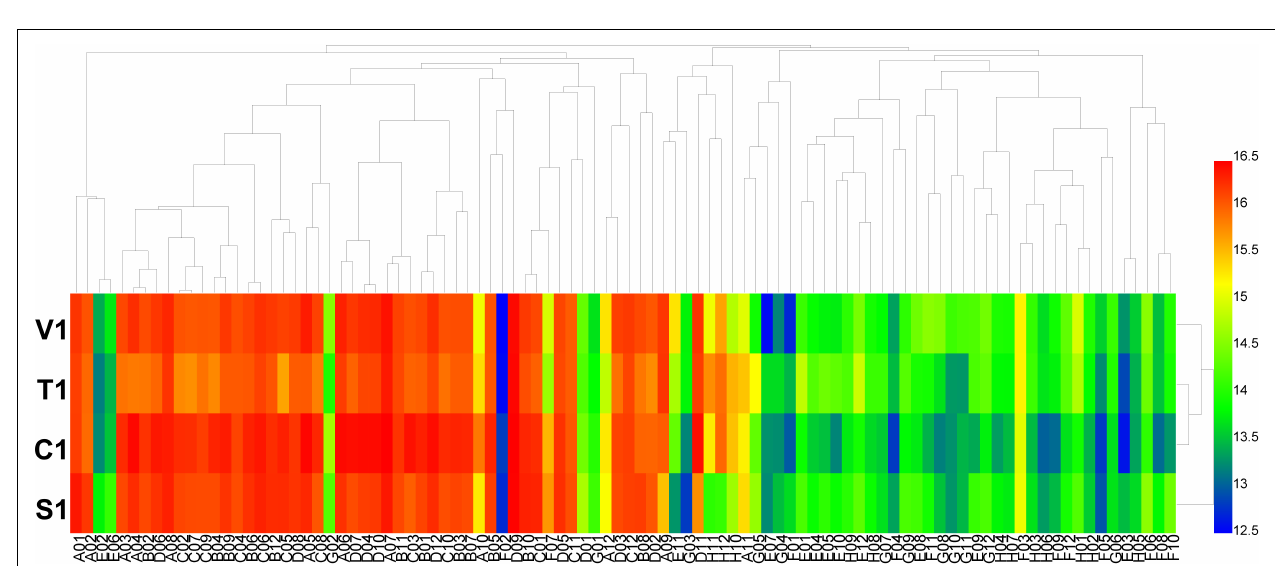
FIGURE 4 | Overview of metabolic phenotypes of four isolates of B. cinerea at 96 osmotic and ionic (O) conditions tested. V1, T1, C1, and S1 were the isolates of B. cinerea from tomato, tobacco, cucumber, and strawberry, respectively. Heatmap of maximum area values of 96 O conditions expressed as maximum curve area monitored during 96 h of incubation. The legend of color code from blue to green, and red shades indicate low, moderate, and high metabolisation at O conditions, respectively, assessed as arbitrary Omnilog values.